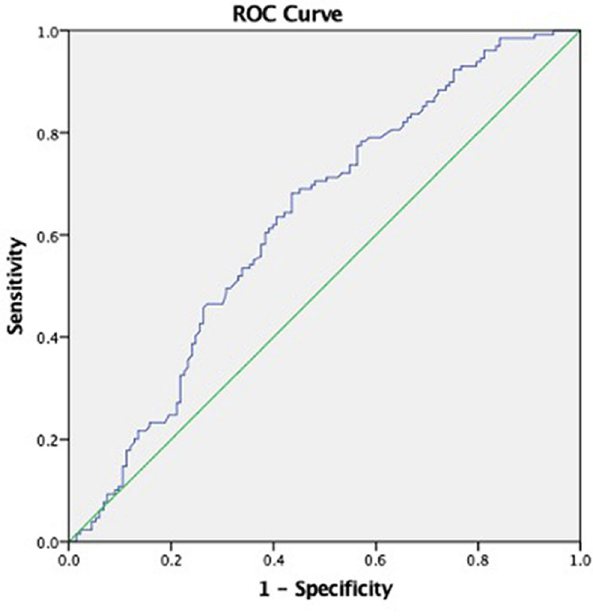
Figure 3. Cut off point body mass index: AUC = 0.629; BMI = 24.785 kg/m 2 ; sensitivity 60.5%, specificity